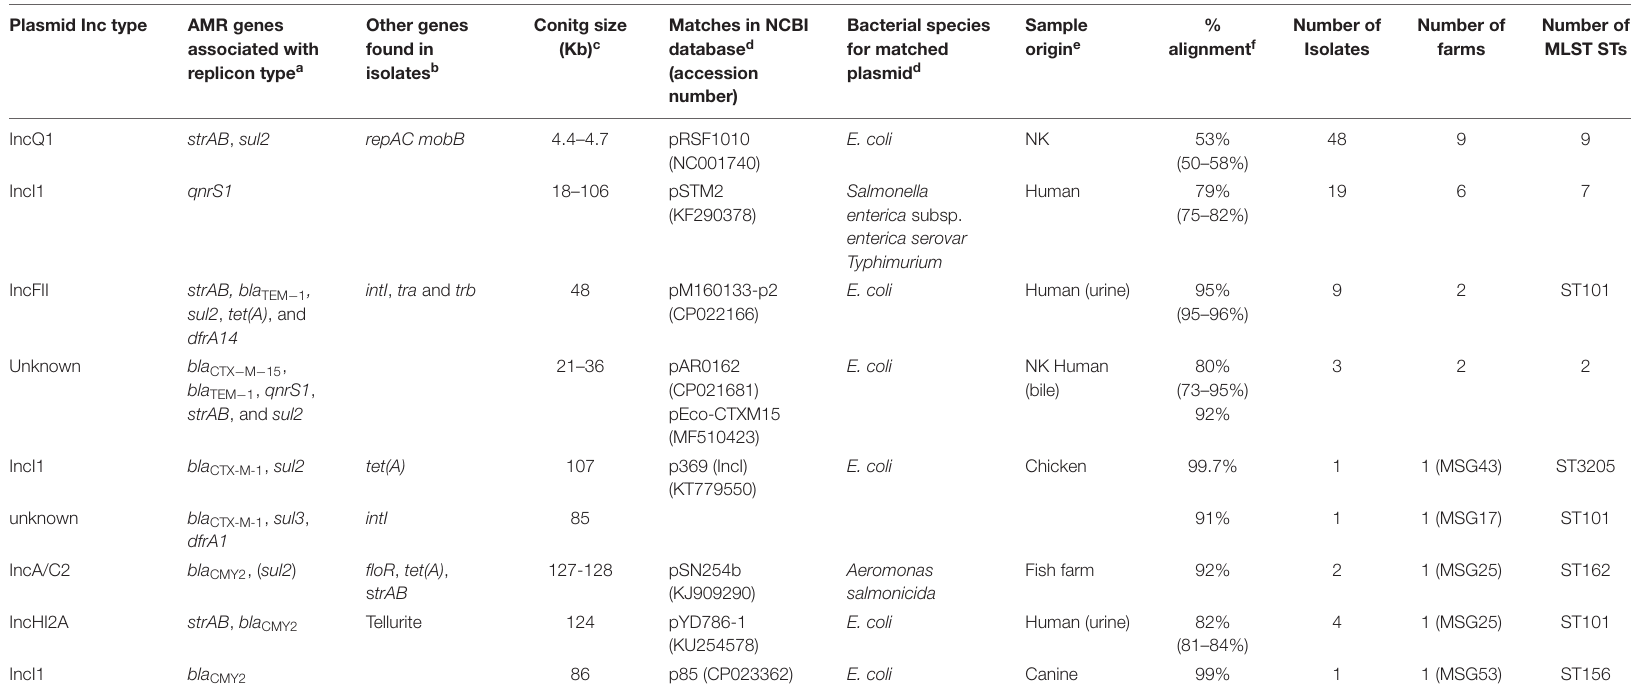
TABLE 2 | Plasmids involved in AMR gene dissemination.